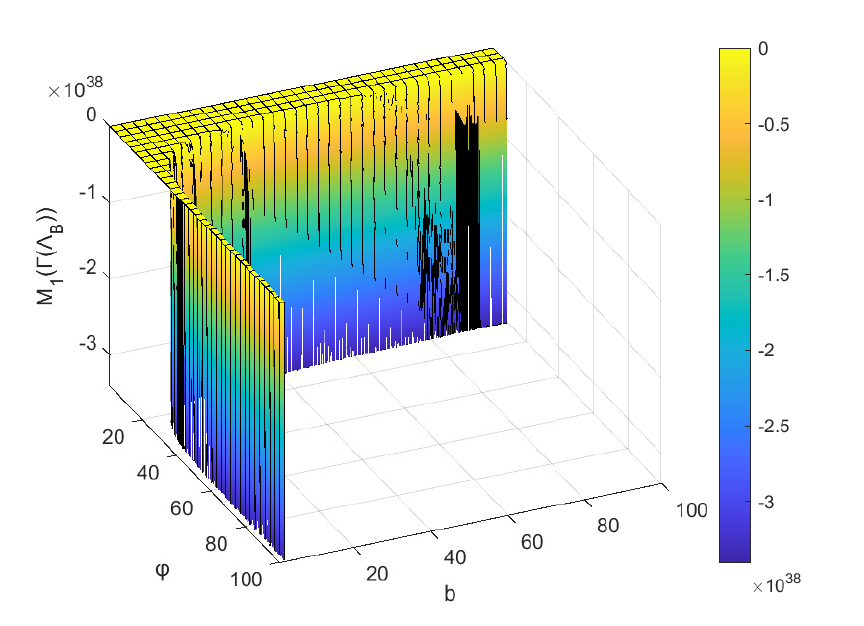
Figure 2. First Zagreb index of Γ ( Λ (cid:66) )